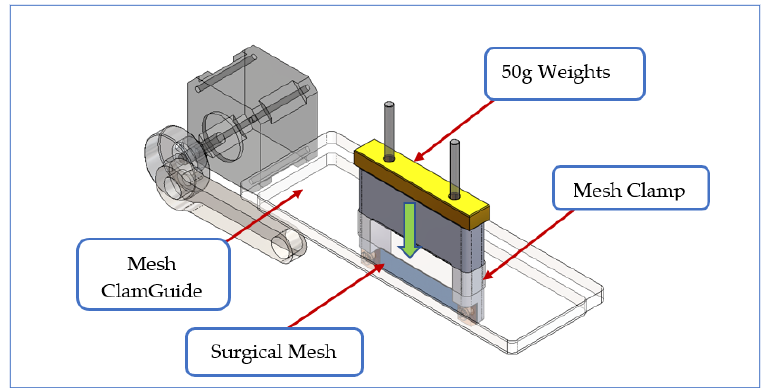
Figure 4. Mesh holder and guide to ensure free vertical movement .